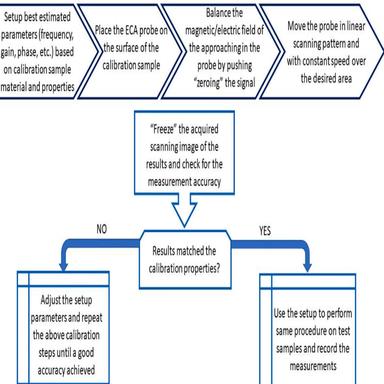
Workflow of ECA testing.